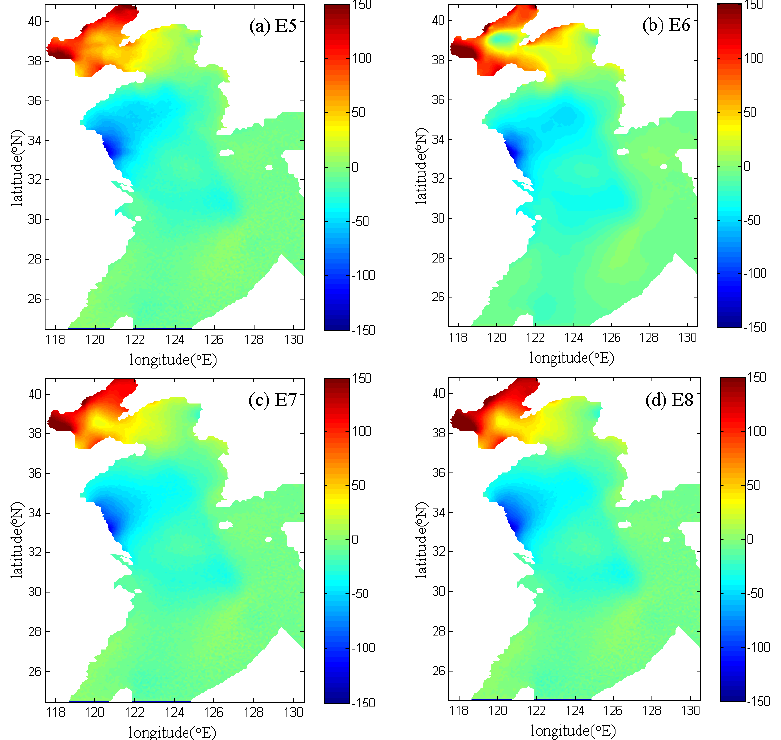
Figure 8. Spatially distributed levels calculated by the pure storm surge model in E5 – E8 at 02:00 pm on 27 July 1972 during Typhoon 7203.